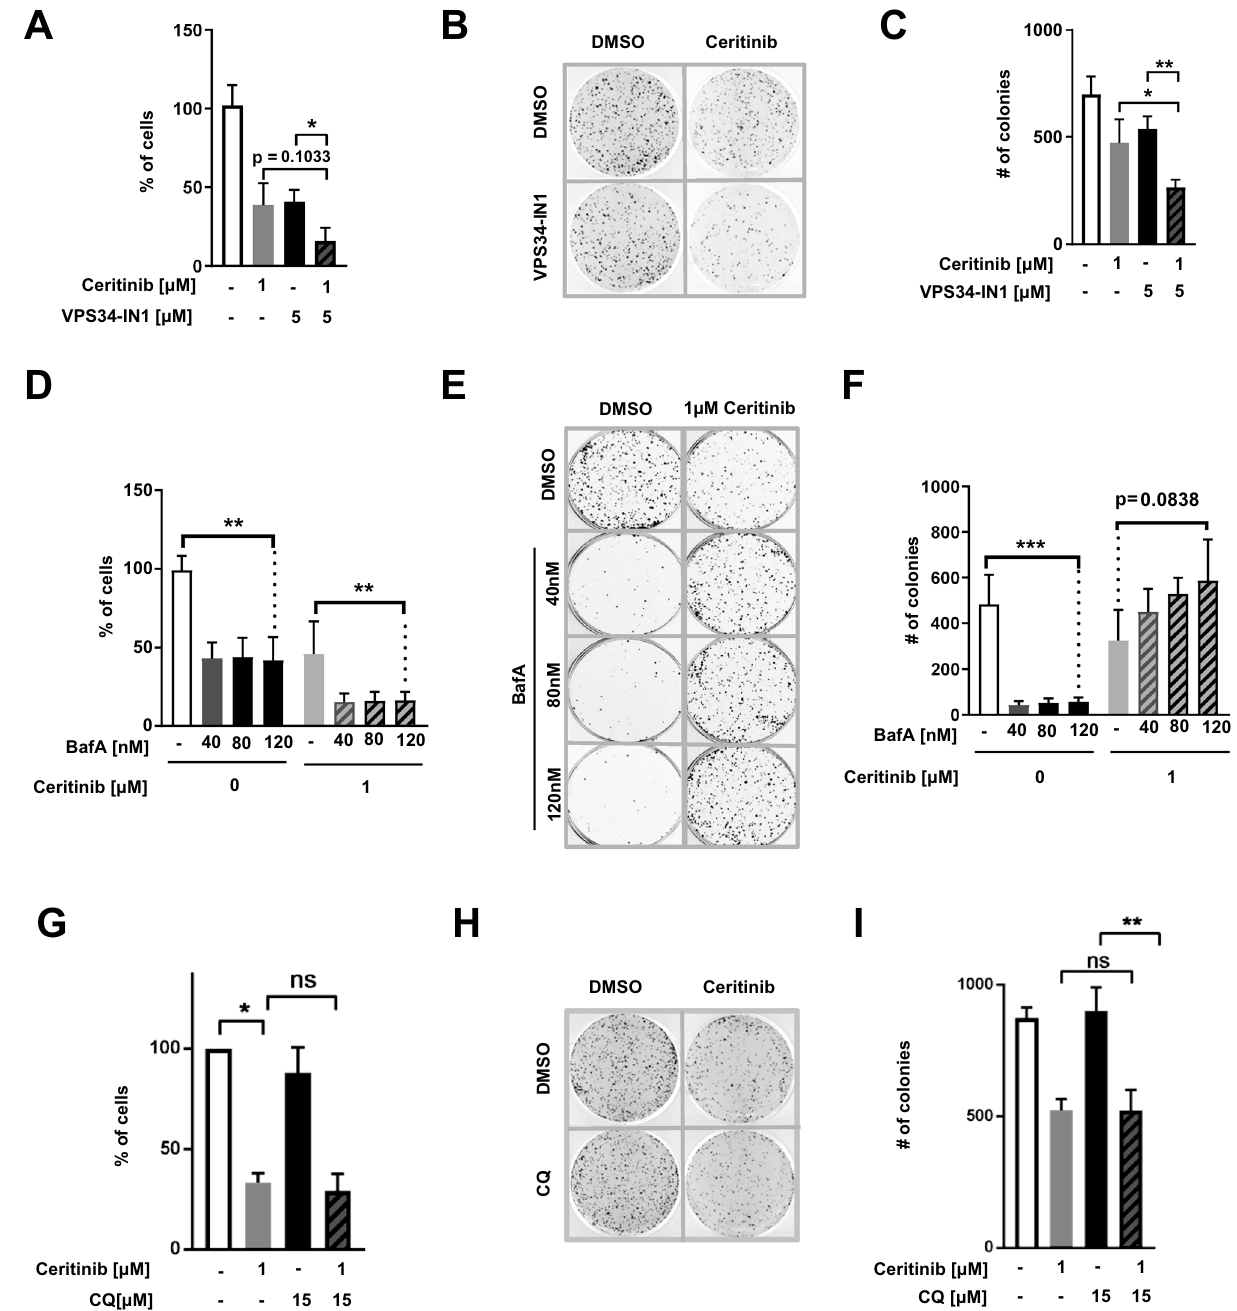
Figure 3. Blocking autophagy via VPS34 inhibition sensitizes cells to Ceritinib ( A ) H3122 cells were treated with DMSO or 1 µM Ceritinib in the presence or absence of VPS34-IN1 for 2 days before living cells were counted and re-seeded for clonogenic assays. Bar plot represents percent of living cells compared to control treated cells (n = 4). ( B ) Clonogenic assay of experiments as described in A. After 2 days of treatment, 5 × 10 3 living cells were re-seeded and kept for 10 days without treatment. Thereafter, colonies were stained with crystal violet and counted. ( C ) Quantification of the clonogenic assays described in A (n = 4). ( D ) H3122 cells were treated with DMSO or 1 µM Ceritinib in the presence or absence of increasing concentrations of BafA (40, 80 and 120 nM) for 2 days before living cells were counted and quantified from 5 independent experiments as in A. ( E ) Clonogenic assay of cells as described in D. Living cells were re-seeded at low density (5 × 10 3 cells per well in a 6-well plate) and cultured in the absence of drugs for 10 days. Colonies were counterstained using crystal violet and counted. ( F ) Quantification of colonies shown in E (n = 5). ( G ) H3122 cells were treated with DMSO or 1 µM Ceritinib in the presence or absence of 15 µM chloroquine and asssessed as in A (n = 3). ( H ) Clonogenic assay of chloroquine (CQ) treated cells as described in G and assessed as in B. ( I ) Quantification of colonies shown in H (n =